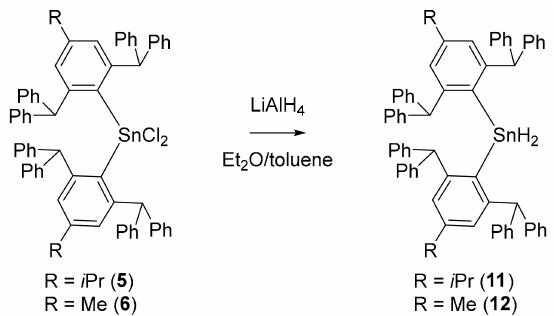
Figure 4. Hydrogenation of diaryltin dichlorides 5 and 6 utilizing LiAlH 4 leads to corresponding diaryltin dihydrides 11 and 12 , respectively.